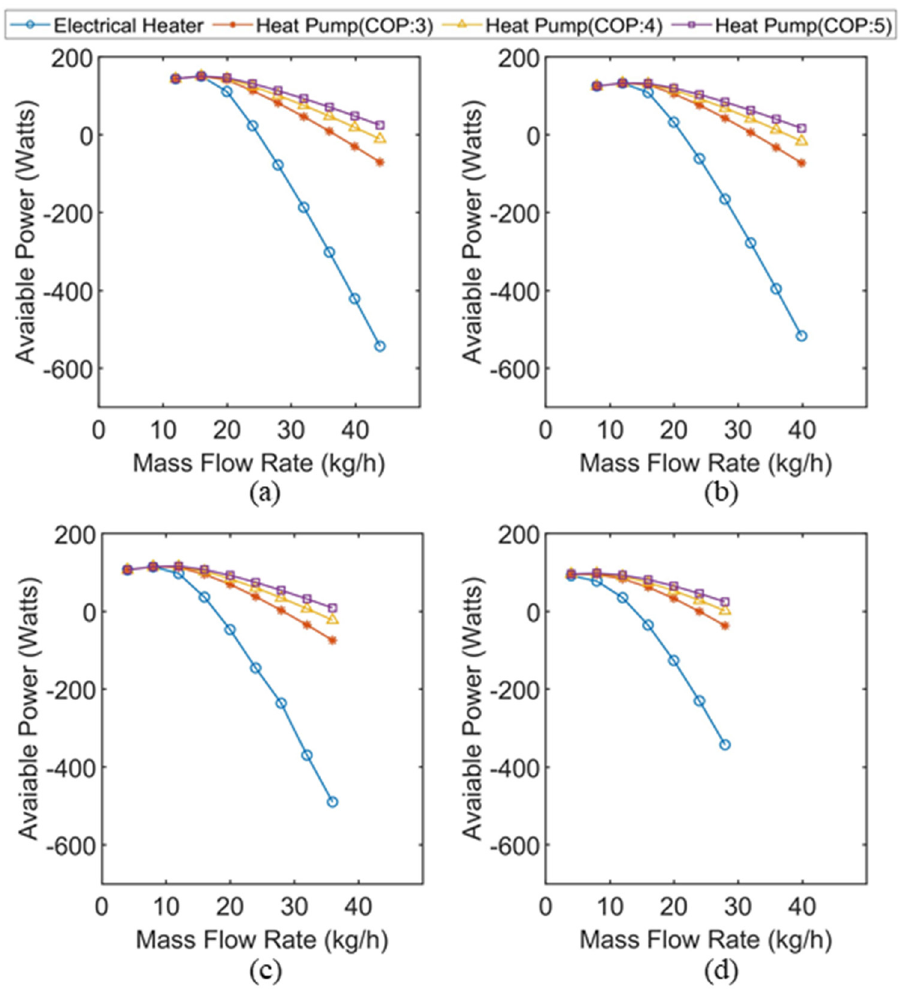
Figure 9. Available electrical power after delivering domestic hot water by different backup systems coupled with unglazed PVT system at irradiance of: ( a ) 1000 W/m 2 ; ( b ) 900 W/m 2 ; ( c ) 800 W/m 2 ; ( d ) 700 W/m 2 .